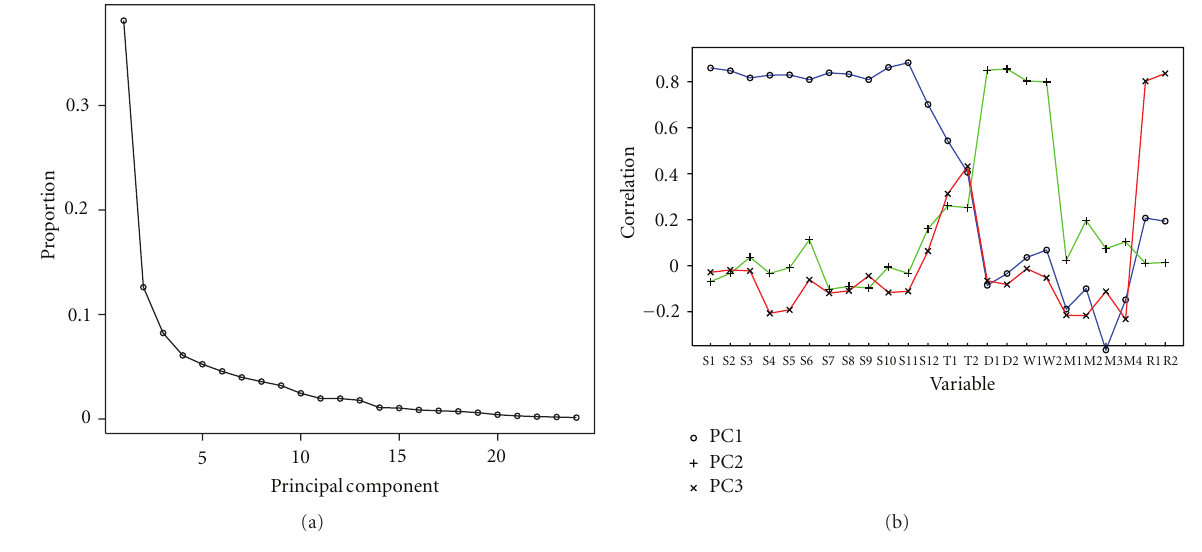
Figure 2: (a)Proportion of variation explained by each principal component based on all 24 CATSYS measures, and adjusted for age. The first 3 principal components account for the majority total data variation ( ∼ 60%). (b) The 24 individual variables of the CATSYS and their correlation to the first 3 principal components. The first PC (PC1) summarizes predominantly all sway tasks; the second PC (PC2) is primarilycorrelated with intentiontremor (DotTrem) and writing tremor (WritTrem)in both hands;the third PC (PC3)captures association with postural tremor (TremInt) and reaction time in both hands. S1: SwayO60 Mean , S2: SwayO60 Area , S3: SwayO60 Int , S4: SwayO30 Mean